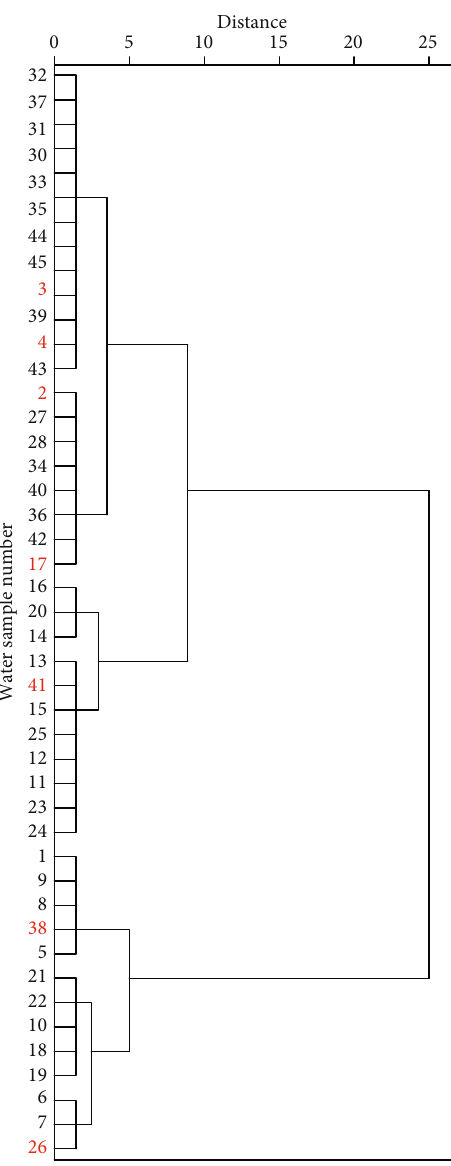
Figure 3: Q-type cluster analysis results of original water